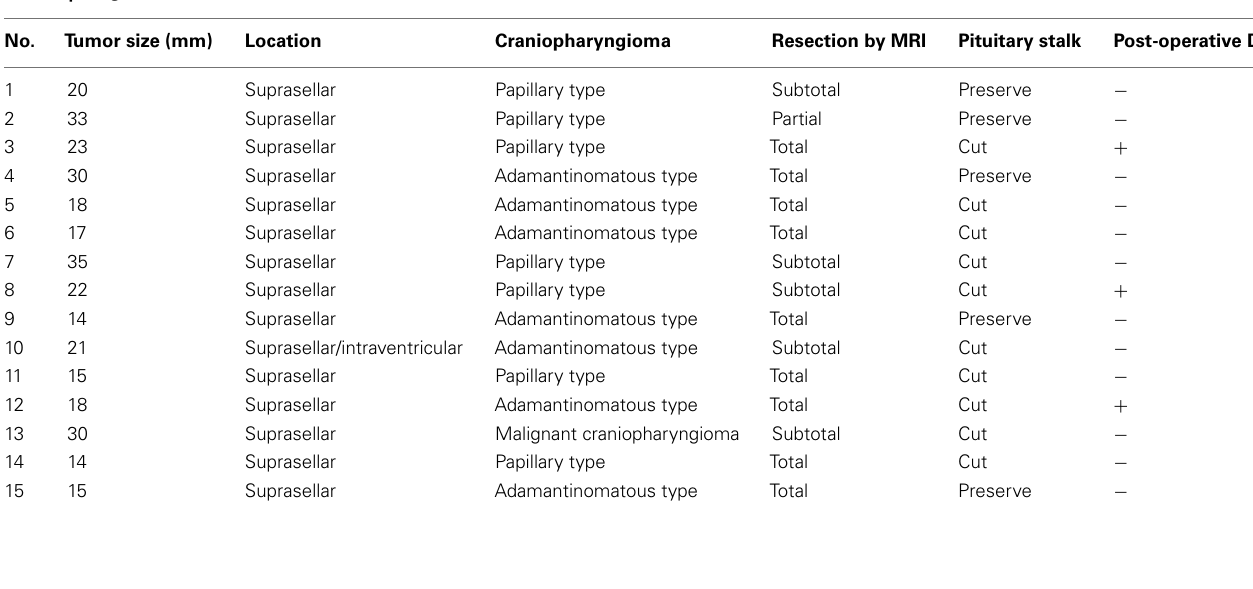
Table 2 | Surgical